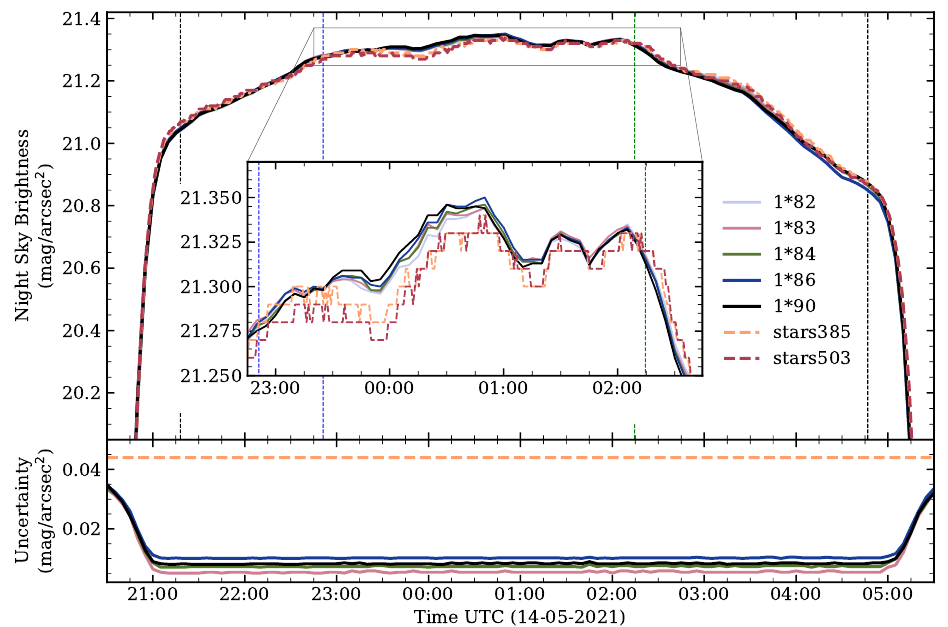
Figure 9. NSB curve of five SG-WAS (1 ∗ X) and two TESS-W (starsX) photometers taken on 2021 May 14 from Teide Observatory (Canary Islands, Spain). The vertical lines indicate the end ( left ) and beginning ( right ) of astronomical twilight (black), the leaving of the zodiacal light (blue) and the entrance of the Galaxy (green) in the FOV of the device. The inner graph shows the dark period [10] enlarged. The SG-WAS curves are smoother than those of TESS-W as a consequence of the 10- measurement averaging process. The lower plot shows the total uncertainty in the measurements, including the instrumental error—calculated for each SG-WAS measurement and its upper bound of 0.004 mag/arcsec 2 for TESS-W—and the calibration error—obtained by the SIS method for SG-WAS and 0.044 mag/arcsec 2 for